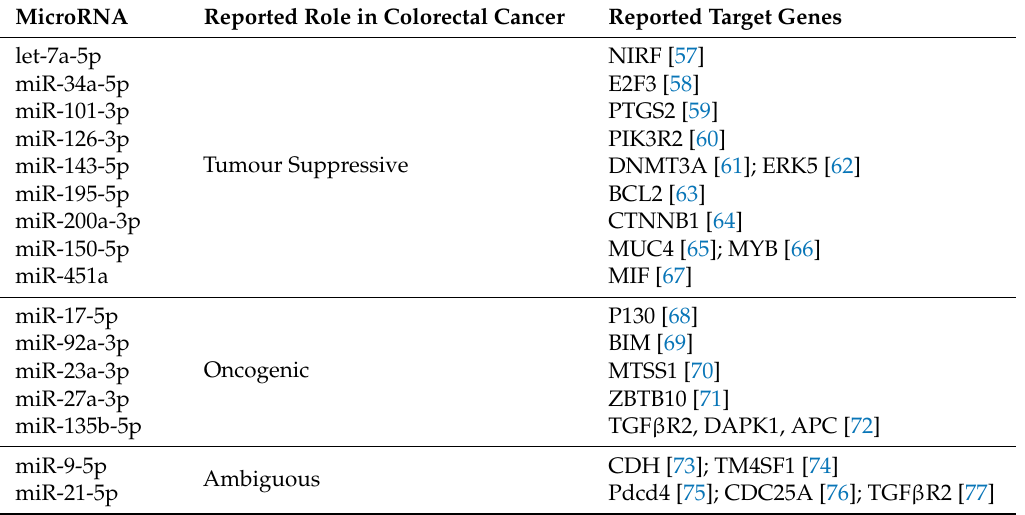
Table 1. Listed examples of reportedly tumour suppressive, oncogenic and ambiguous miRNAs and their reported target